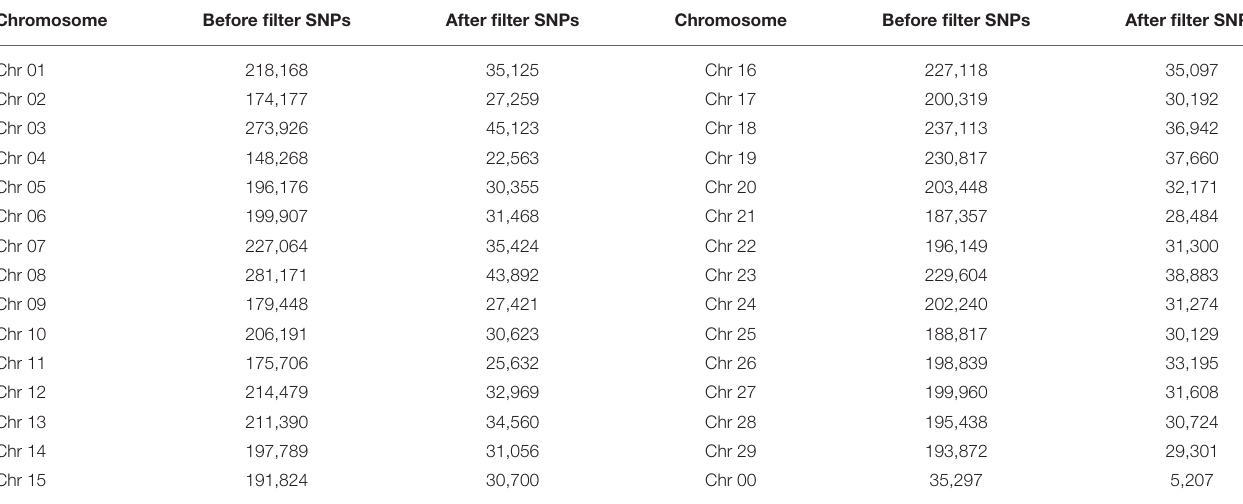
TABLE 4 | Distribution of single nucleotide polymorphisms (SNPs) on each